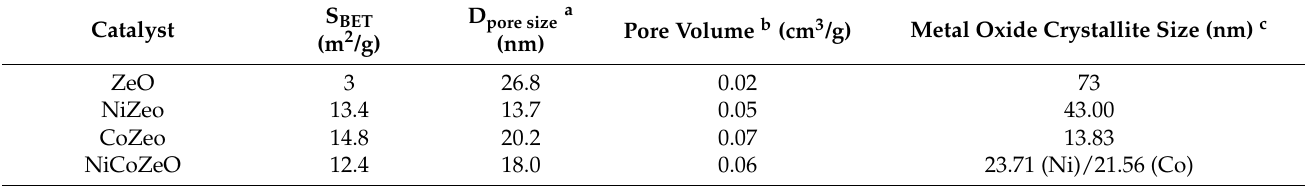
Figure 3. N 2 adsorption-desorption isotherms. ( a ) Zeolite, ( b ) NiZeo, ( c ) CoZeo and ( d ) NiCoZeo. Table 1. Textural properties of zeolite and